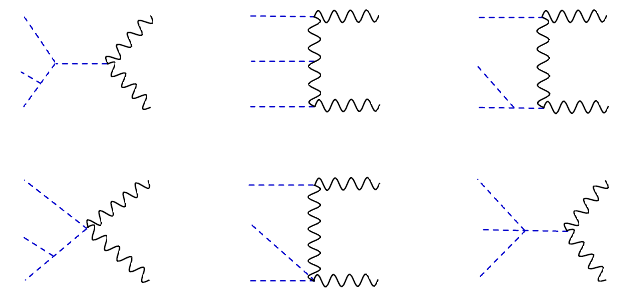
Figure 14 . Feynman diagrams for the annihilation SSS ! XX .